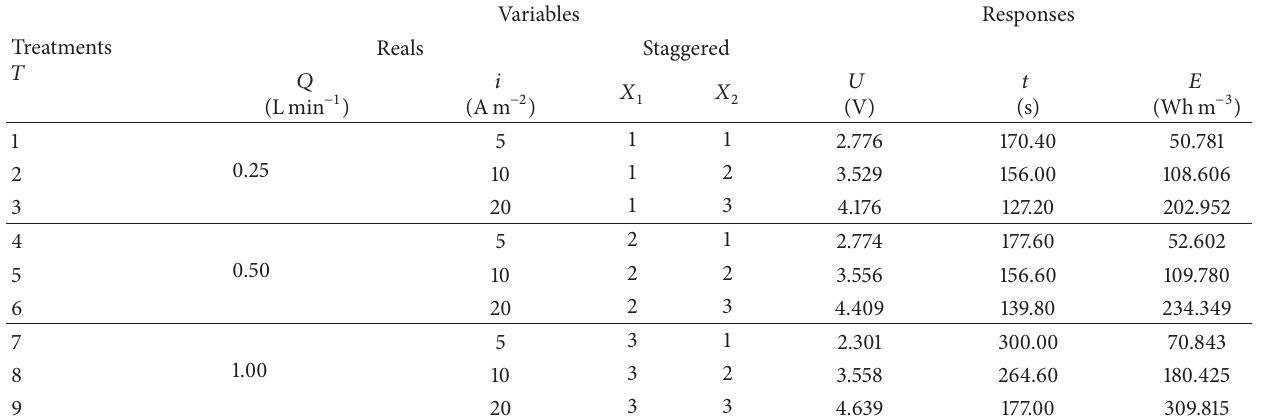
Table 3: Processing parameters of the 3 2 factorial design and values of response variables obtained during the EC treatments performed in the perfectly mixing